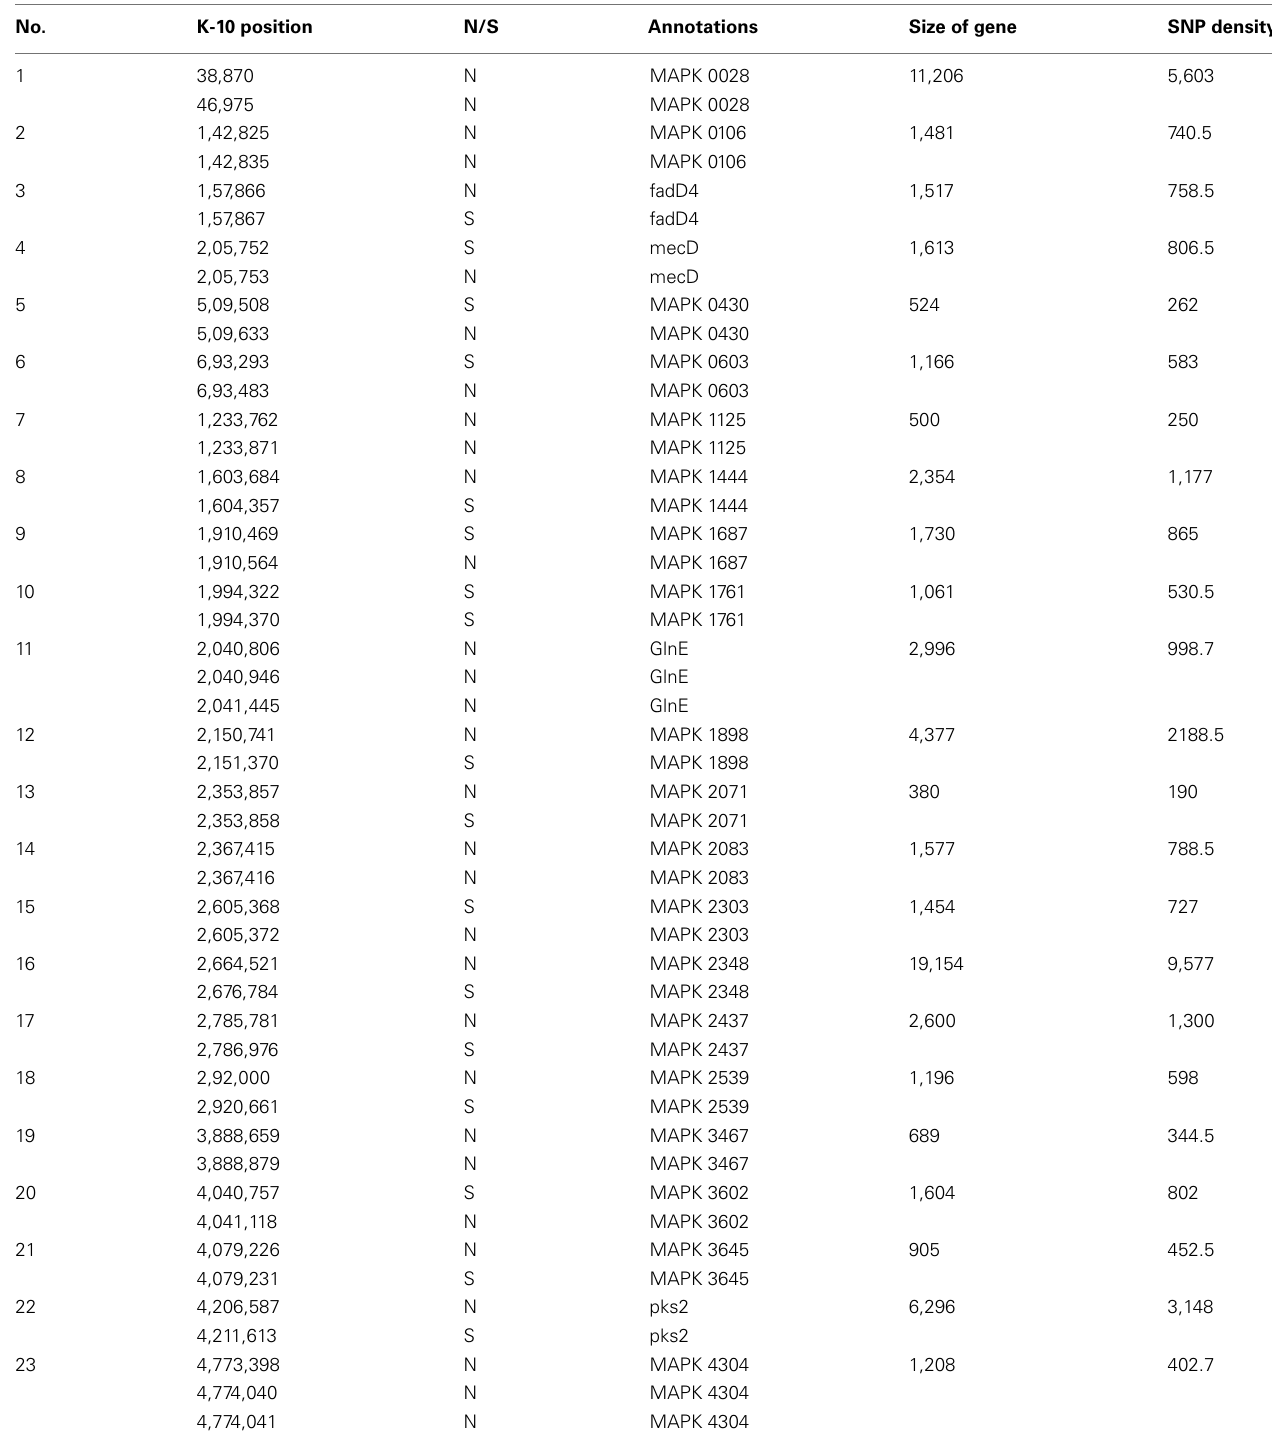
TableA2 |A list of genes that harbored > 1 SNPs and its SNPs density.